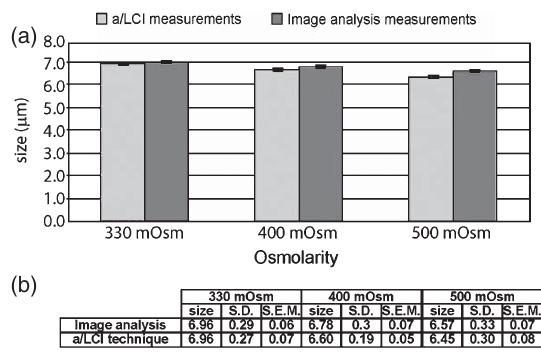
Fig. 8. Comparison of measurements of porcine chondrocyte cell nuclei using (a) image analysis and (b) the a/LCI technique. The error bars correspond to mean ± SE (standard error of the mean in the95%confidenceinterval).Bothexperimentsdemonstrateastatis- tically significant ( p <0.05) increase in nuclear size with decreasing osmolarity. Taken from